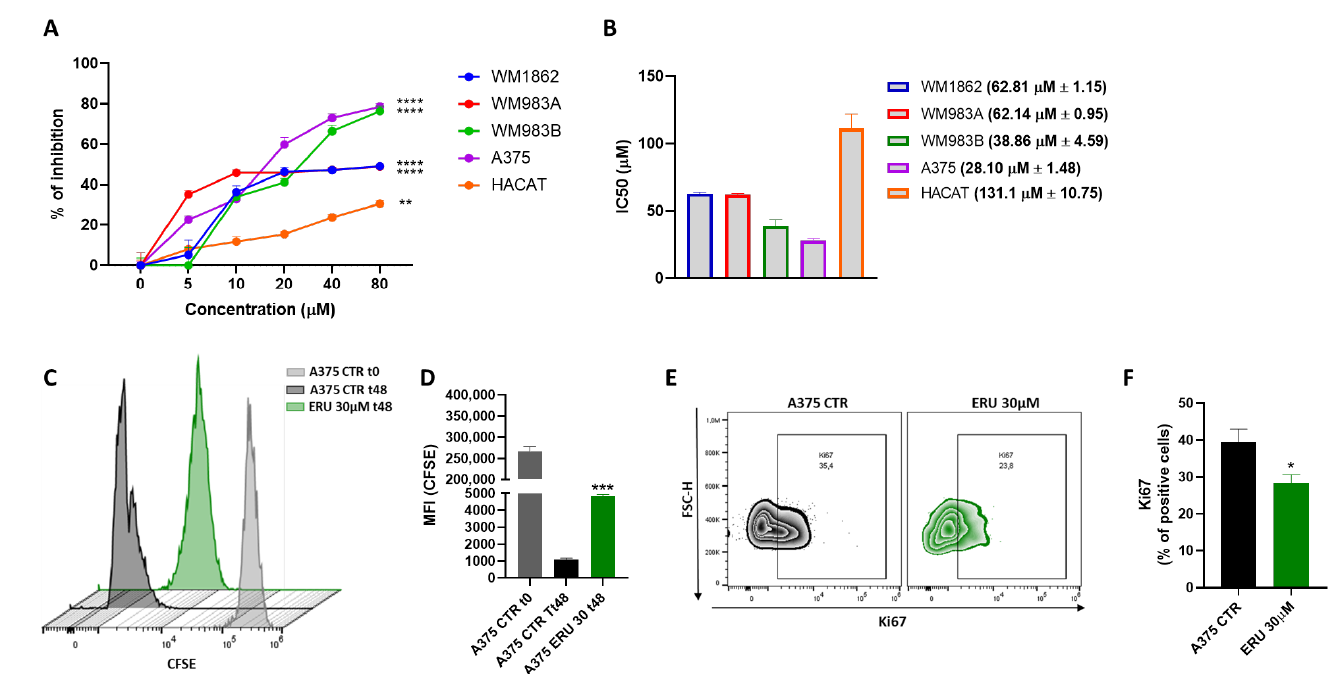
Figure 1. ERU affected the proliferation rate of human melanoma cell lines. ( A ) Antiproliferative effect of ERU (0 –80 μM) was assessed with MTT assay in A375, WM1862, WM983A and WM983B melanoma cells and in normal human keratinocytes (HaCaT) at 48 h. ( B ) IC50 values for ERU-treated A375, WM1862, WM983A and WM983B melanoma cells and for HaCaT cells. ( C ) Representative example of flow cytometry analysis of CFSE staining in A375 cells after staining (grey histogram) and after 48 h of treatment (green histogram) or no treatment (black histogram) with 30 μM ERU. ( D ) CFSE quantification in terms of mean fluorescence intensity (MFI). ( E ) Representative example of flow cytometry analysis of A375-derived Ki67 upon treatment (green dot plot) or no treatment (black dot plot) with 30 μM ERU. ( F ) Frequency of Ki67 in A375 cells after treatment (green bar) or no treatment (black bar) with 30 μM ERU. Data were shown as mean ± SEM of at least three independent experiments (* p < 0.05, ** p < 0.01, *** p < 0.001 and **** p < 0.0001 vs. A375 CTRL).